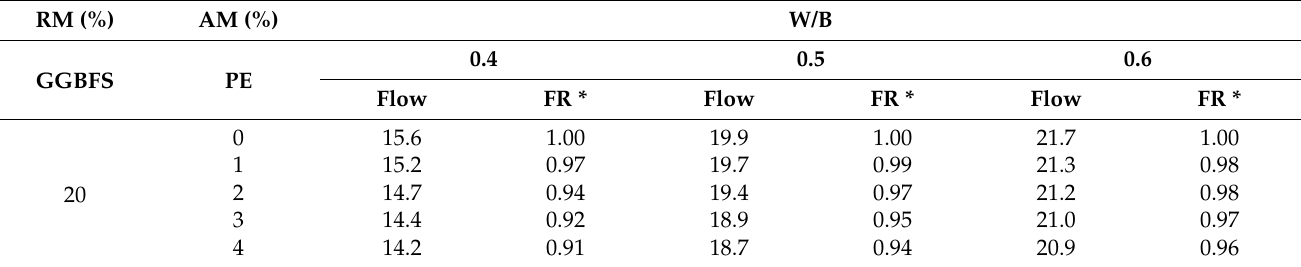
Table 5. Flow and flow ratio of cement mortar with different W/B ratios and waste PE (unit: cm).